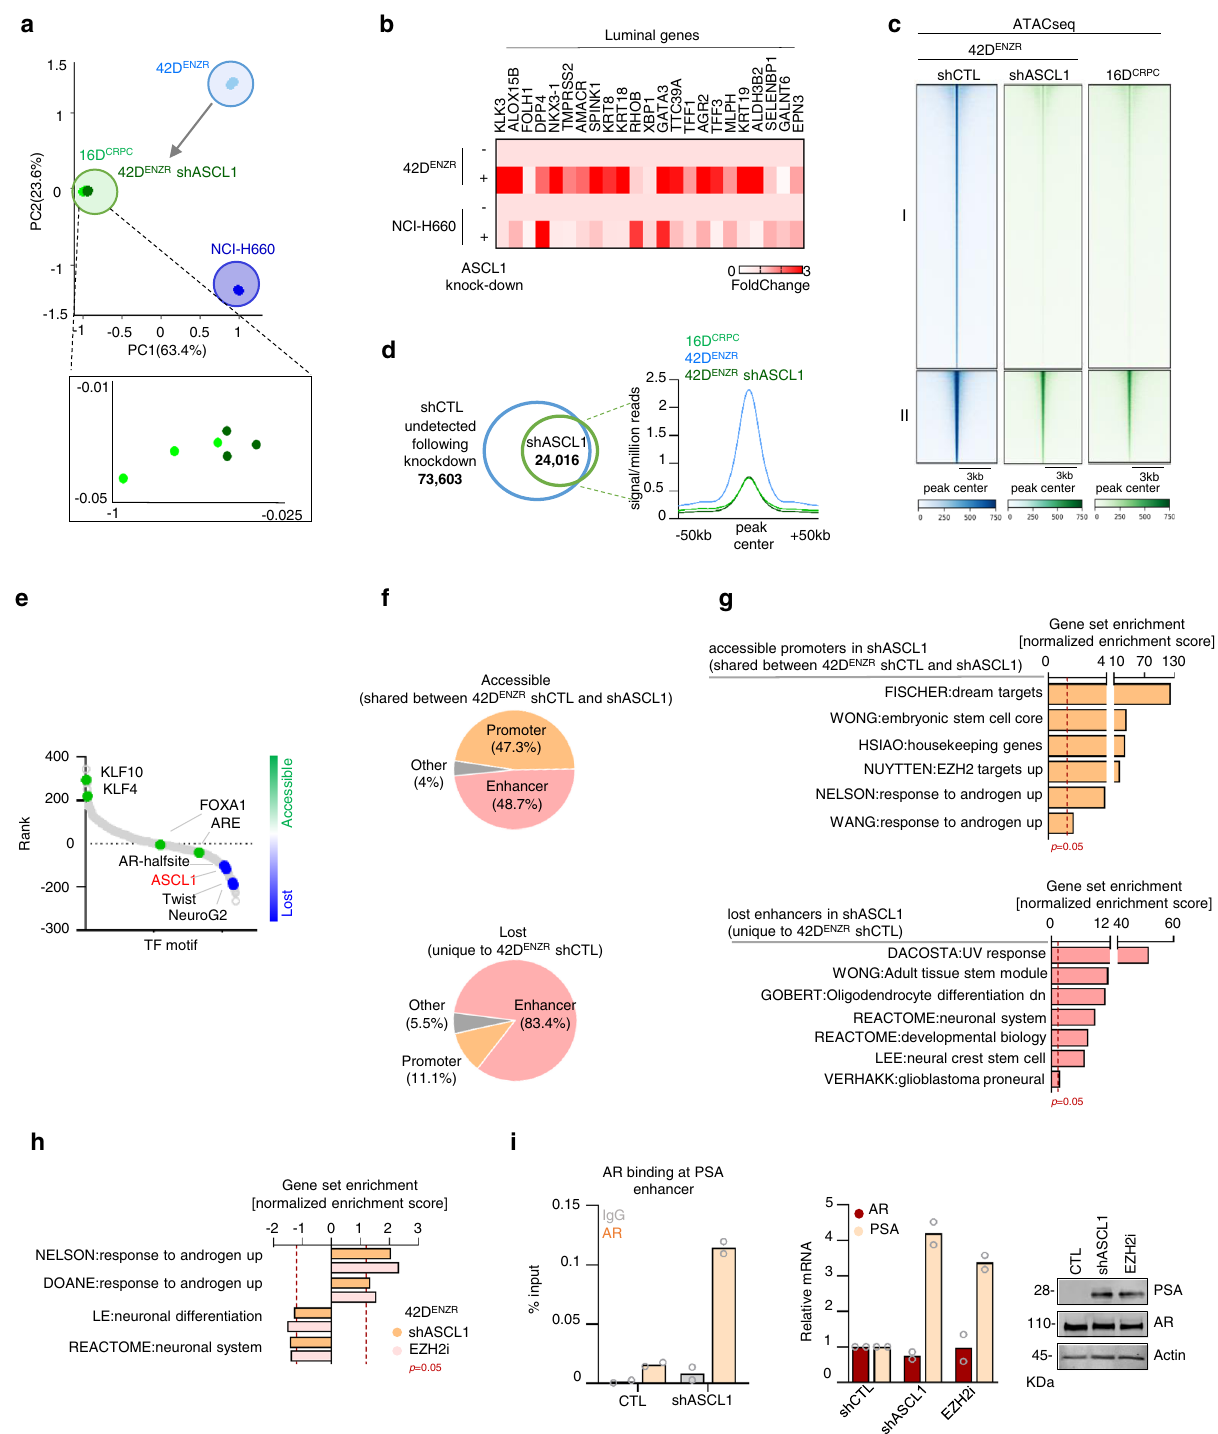
CRISPR/Cas9-based gene editing . For generating stable 42D ENZR with knockout ASCL1, cells were infected with TLCV2 vector (Addgene, cat. #87360) containing an ASCL1-speci fi c guide RNA (GCGTTTGCAGCGCATCAGTT). A non-targeting gRNA (GTATTACTGATATTGGTGGG) was used as a control. At 5 days post- transfection, cells expressing Cas9/gRNA plasmid were isolated by FACS, seeded at single-cell density, and expanded. PCR of genomic DNA from individual clones was performed with primers fl anking the gRNA target site and assayed by Sanger sequencing. Lentiviral vector preparation and infection . HEK293T cells were plated at 80% con fl uency 1 day prior to transfection in complete medium. Cells were transfected